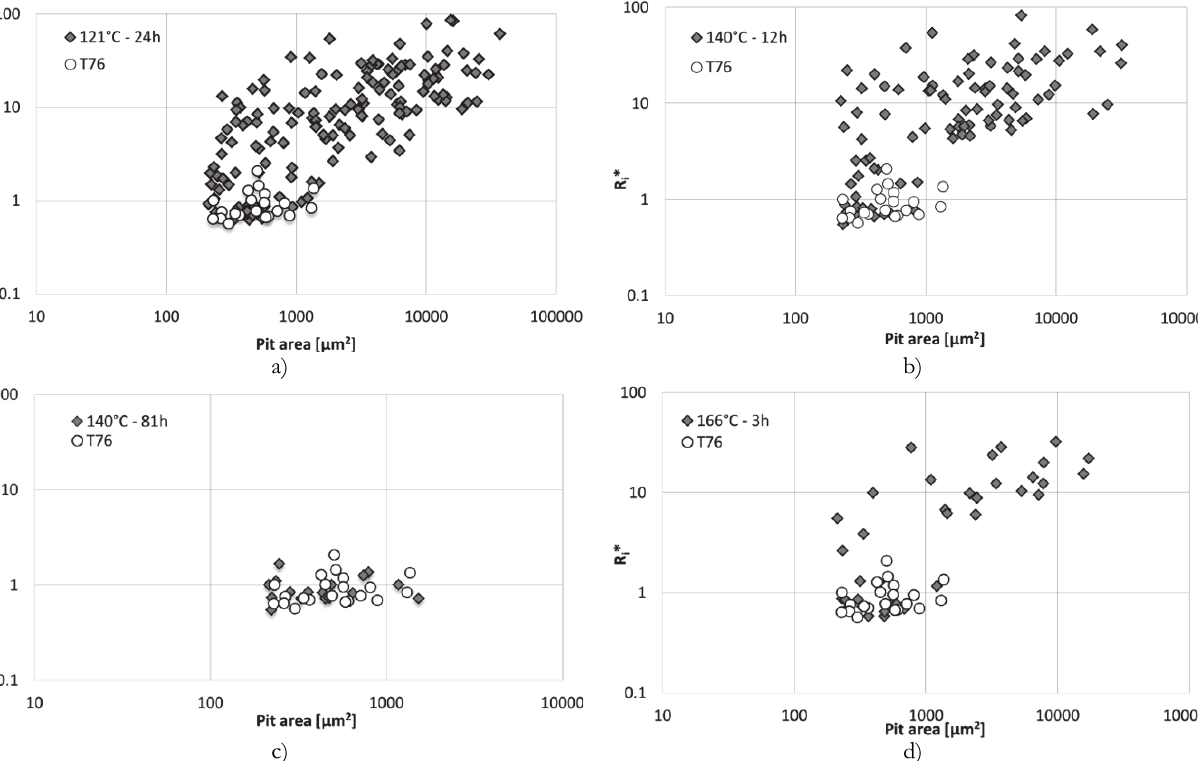
Figure 8: Modified roundness vs pit area for different ageing parameters compared with T76 temper.